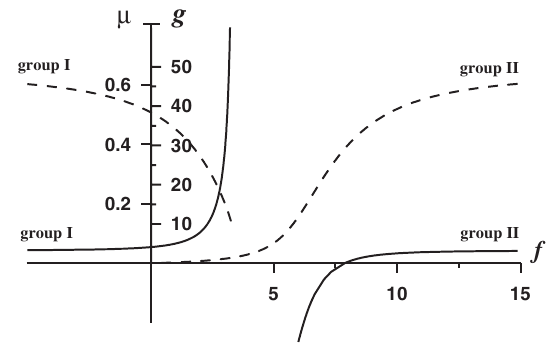
FIG. 5. The bunching parameter (cid:9) (solid line) and frequency up-conversion coefficient g (dashed line) at the equilibrium helical trajectory for the groups of orbits I and II as a function of guide magnetic field strength f ( (cid:3) ¼ 5 , (cid:4)